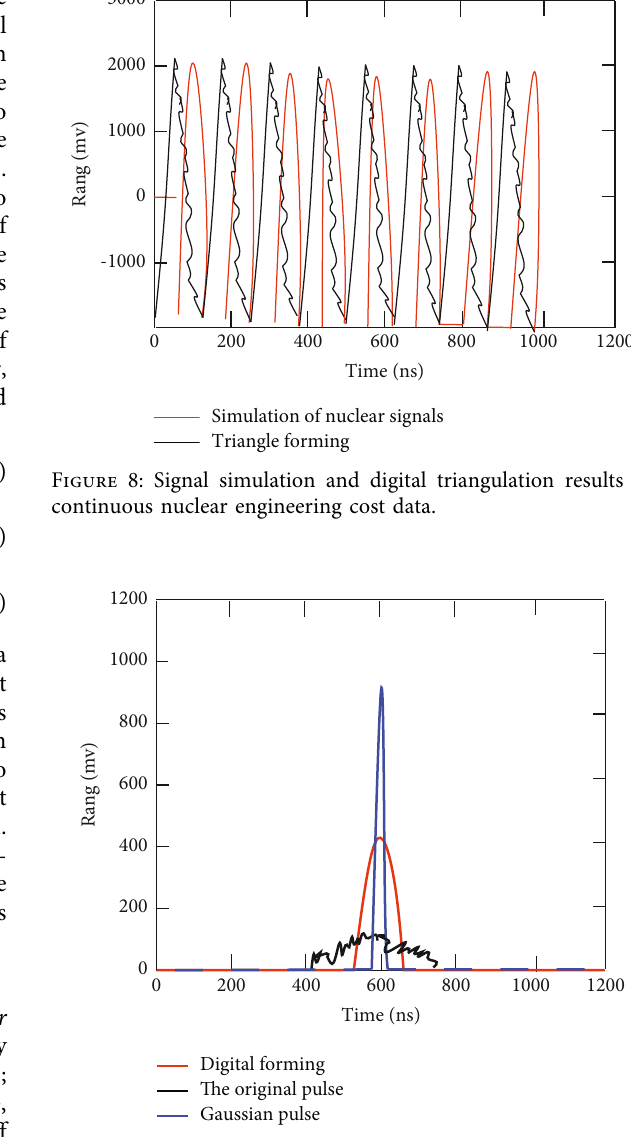
Figure 9: Amplitude spectrum distribution of analog and digital engineering cost data signal (original pulse +triangular